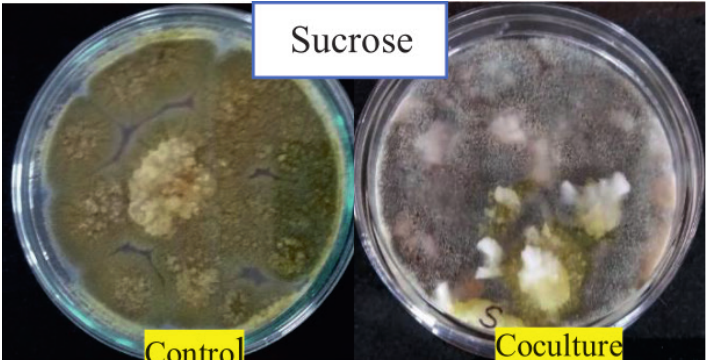
Fig. 3. Percentage inhibition of A. flavus growth in different carbon sources showing highest inhibition with sucrose as carbon source. Inhibition percentage = (Control- Test/ Control) x100. Values are represented as Mean ± SD (n=5). *Value is statistically significant for P ≤ 0.05 in